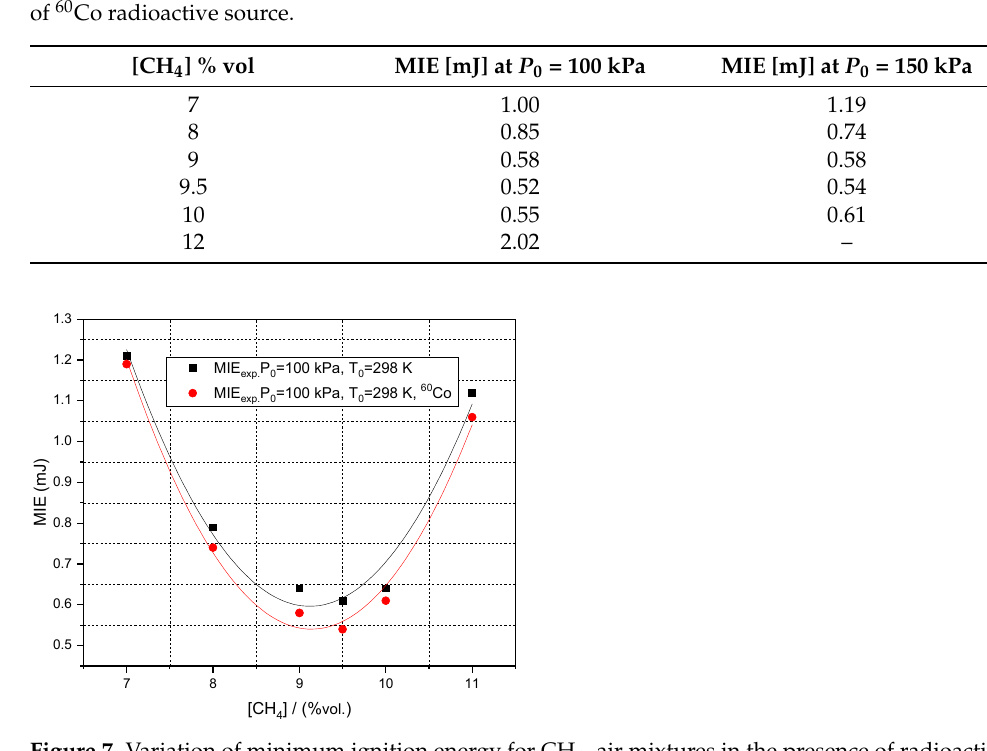
Figure 7. Variation of minimum ignition energy for CH 4 –air mixtures in the presence of radioactive 60 Co source.